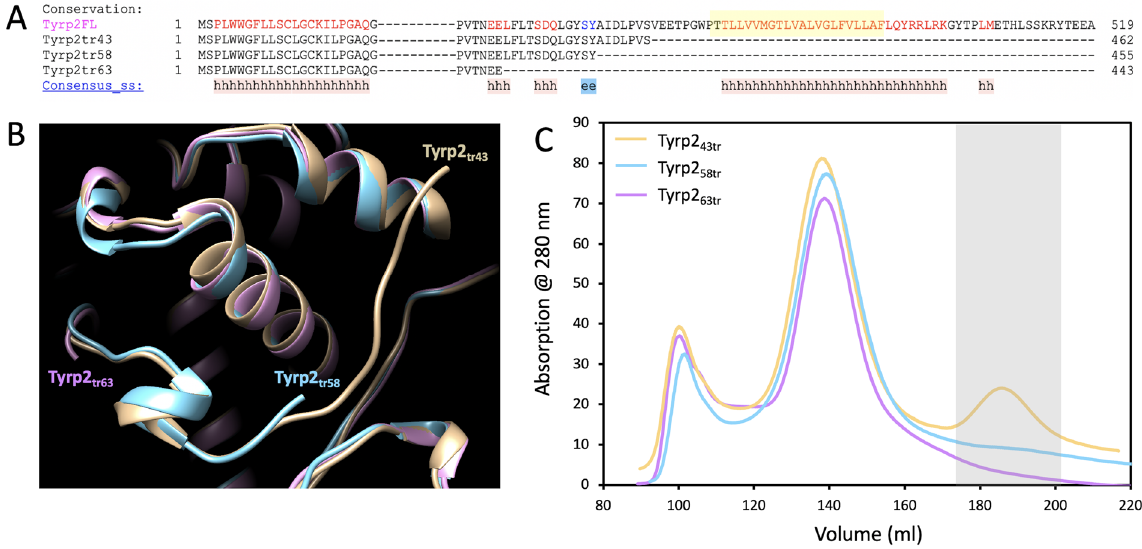
Figure 1. Stability of the human recombinant Tyrp2 proteins with different truncation sites. ( A ) The PROMALS3D sequence alignment (http://prodata.swmed.edu/promals3d/promals3d.php; accessed on 20 January 2022) of human Tyrp2 full length (Tyrp2FL, P40126 UniProtKB) and the Tyrp2 sequences with three amino acid truncation lengths: 43 (Tyrp2tr43), 58 (Tyrp2tr58), and 63 (Tyrp2tr63) . Representative Tyrp2FL sequence (magenta) is colored according to predicted secondary structures (red: alpha-helix, blue: beta-strand). Symbols for consensus predicted secondary structure (Consensus_ss) is h for alpha-helix and e for beta-strand. Highlighted with yellow is the transmembrane domain of Tyrp2FL. ( B ) The superimposed structures of Tyrp2 tr43 (tan ribbon), Tyrp2 tr58 (blue ribbon), and Tyrp2 tr63 (pink ribbon). ( C ) The chromatograms of Tyrp2 tr43 (yellow), Tyrp2 tr58 (blue), and Tyrp2 tr63 (pink) after two steps of purification (IMAC and GF) using the His-Trap Crude 5 mL and HiPrep 26/60 Sephacryl S-300 columns on the ÄKTAxpress chromatography system. The picks of protein of interest are in the grey box.